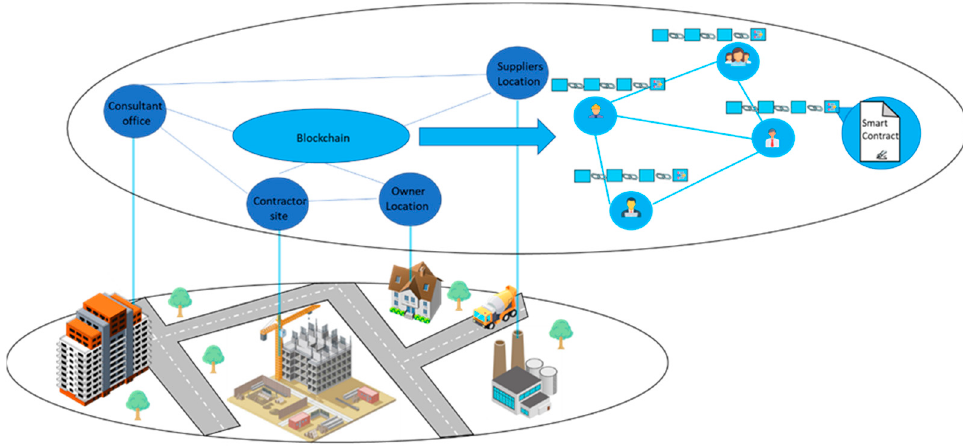
Figure 3. The future vision for blockchain technology with the integration of IoT in the construction industry.